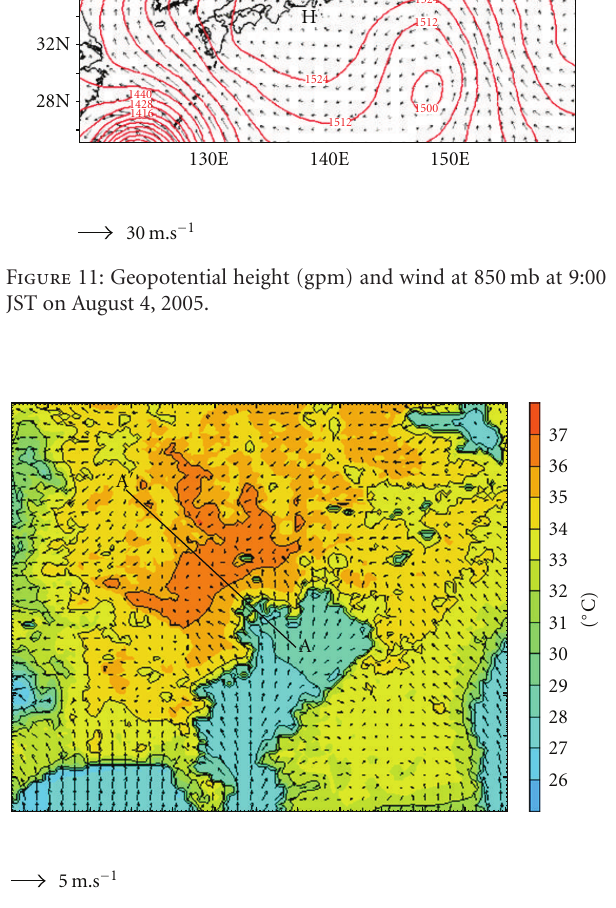
Figure 12: The 2 m temperature ( ◦ C) and 10m wind vector simulated by the MM5 model at 12:00 JST August 4, 2005.